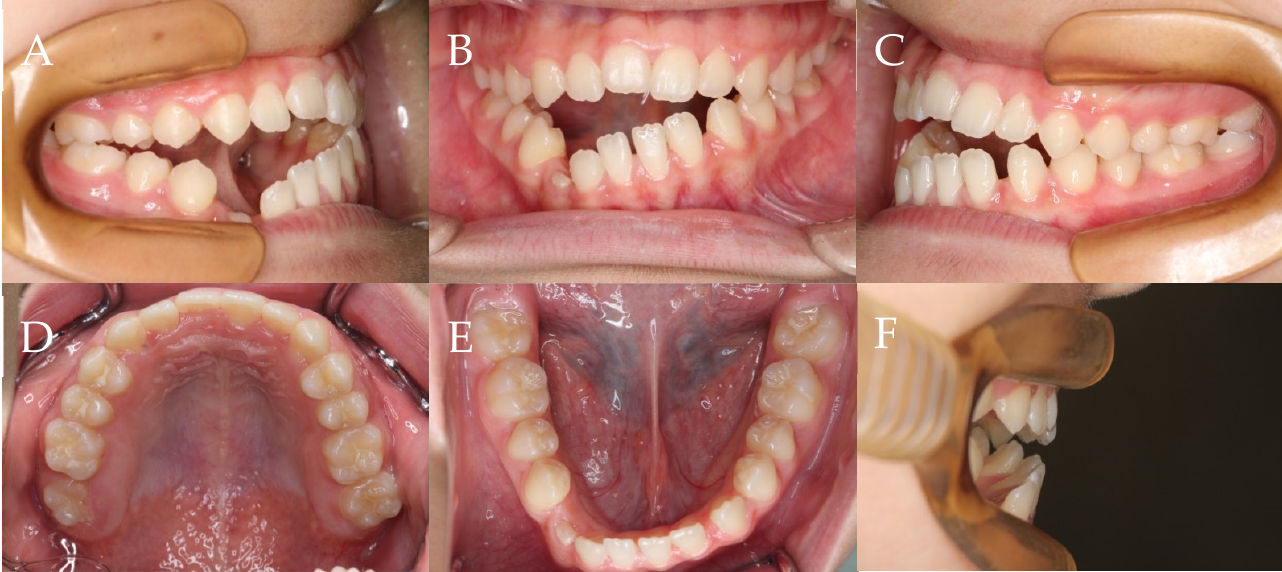
Figure 2. Pre-treatment intraoral photographs. ( A ) Right side view; ( B ) front view; ( C ) left side view; ( D ) upper occlusal view; ( E ) lower occlusal view; ( F ) incisal view. 2.3. History of Past Illness She fell on the ground and landed on her upper and lower right anterior teeth when she was 9 years old. Particularly, she severely hit the upper right central incisor and lower right canine region. The patient did not have any history of systemic illness. She and her parents did not have any history of systemic illness.